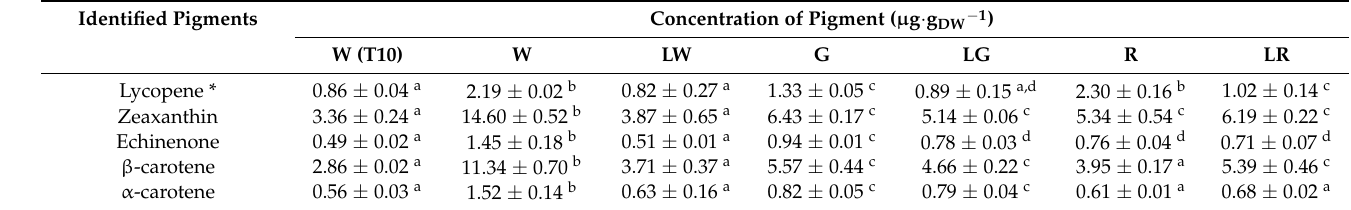
as average ± SD (n = 3) and expressed in µ g · g DW − 1 . For each row, different upper lowercase